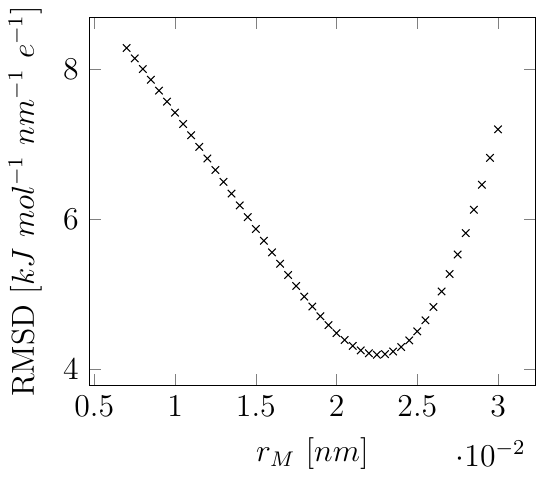
H M Figure 4: Rigid water geometry after QM optimization in the gas phase at the B3LYP/QZ4P level of theory. All bonds are constrained during simulation and the bond angle is enforced by an extra bond between the hydrogens. The location of the off-site (M) particle and its offset are included in the figure. The COS particle is attached to the M-site. O-M distance a gas-phase point charge model was fitted based on the QM determined MEP in vacuum and the resulting molecular static dipole moment was evaluated. For the displace- ment (of 0.0225 nm) that gives a minimum in the Root Mean Square Deviation (RMSD)